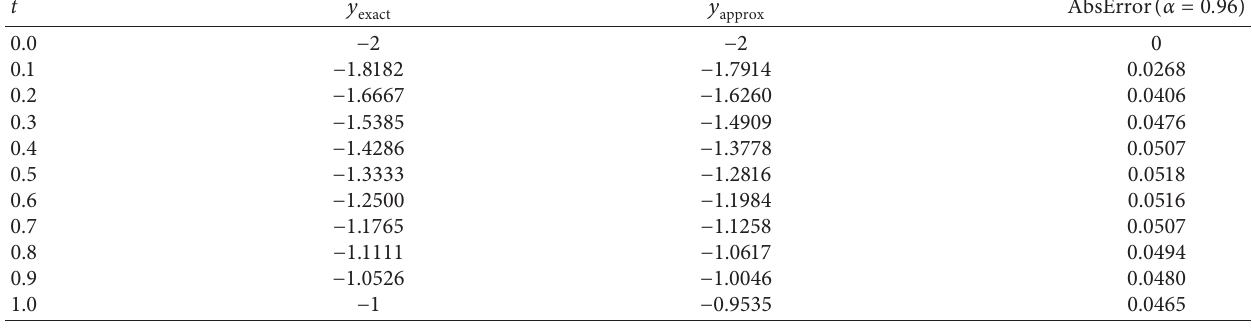
Table 4: Numerical results of Example 2 for α � 0 . 96, with discretization h � 0 . 01.